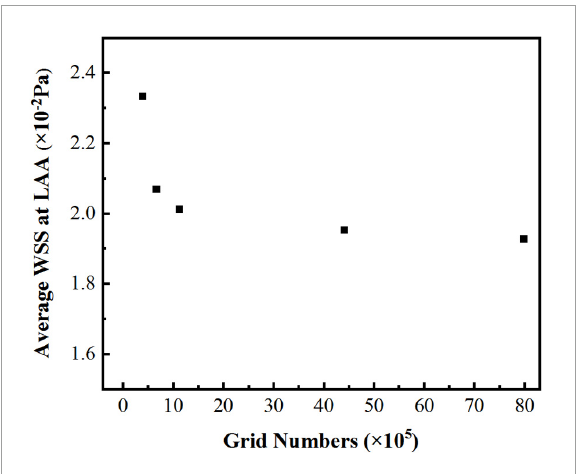
FIGURE3 The average WSS values at LAA with different grid numbers.